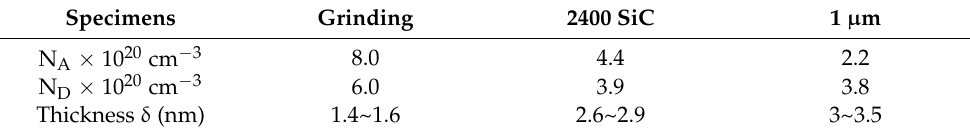
Table 2. Acceptor (N A ) and donor (N D ) densities for 304L SS in borate buffer (pH = 9.2) measured for grinding process, polished samples down to 2400 with SiC and 1 µm with diamond paste Specimens